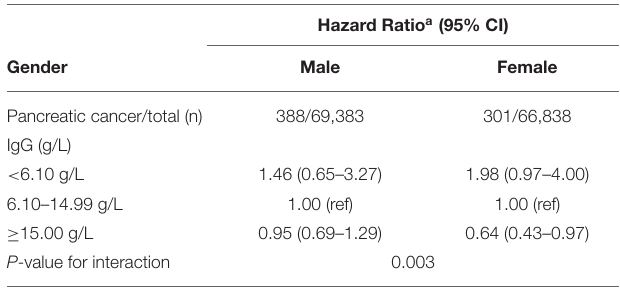
TABLE 3 | Hazard ratio (HR) for risk of pancreatic cancer stratified by gender, in the study population with a measurement of IgG, with 95% confidence intervals from Cox proportional Hazards